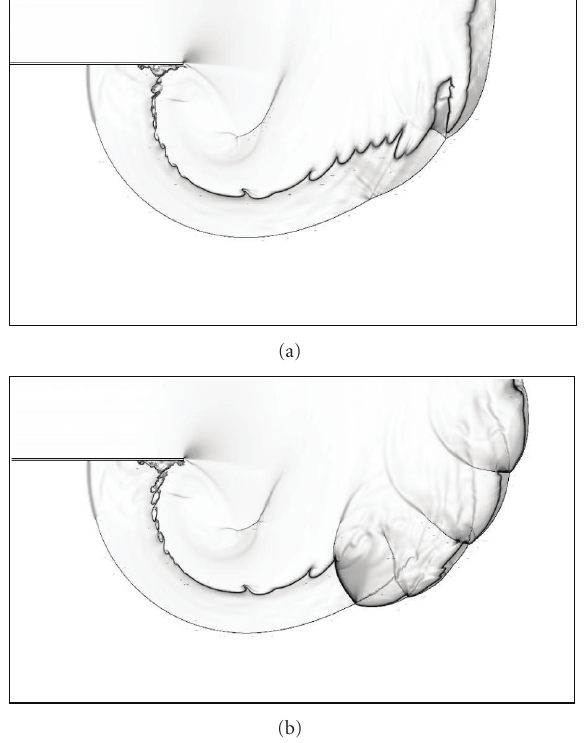
Figure 17: Schlieren plots of the density for a detonation di ff racting out of the two di ff erent tubes. (a) Detonation failure for the width 8 λ , (b) re-ignition for 10 λ